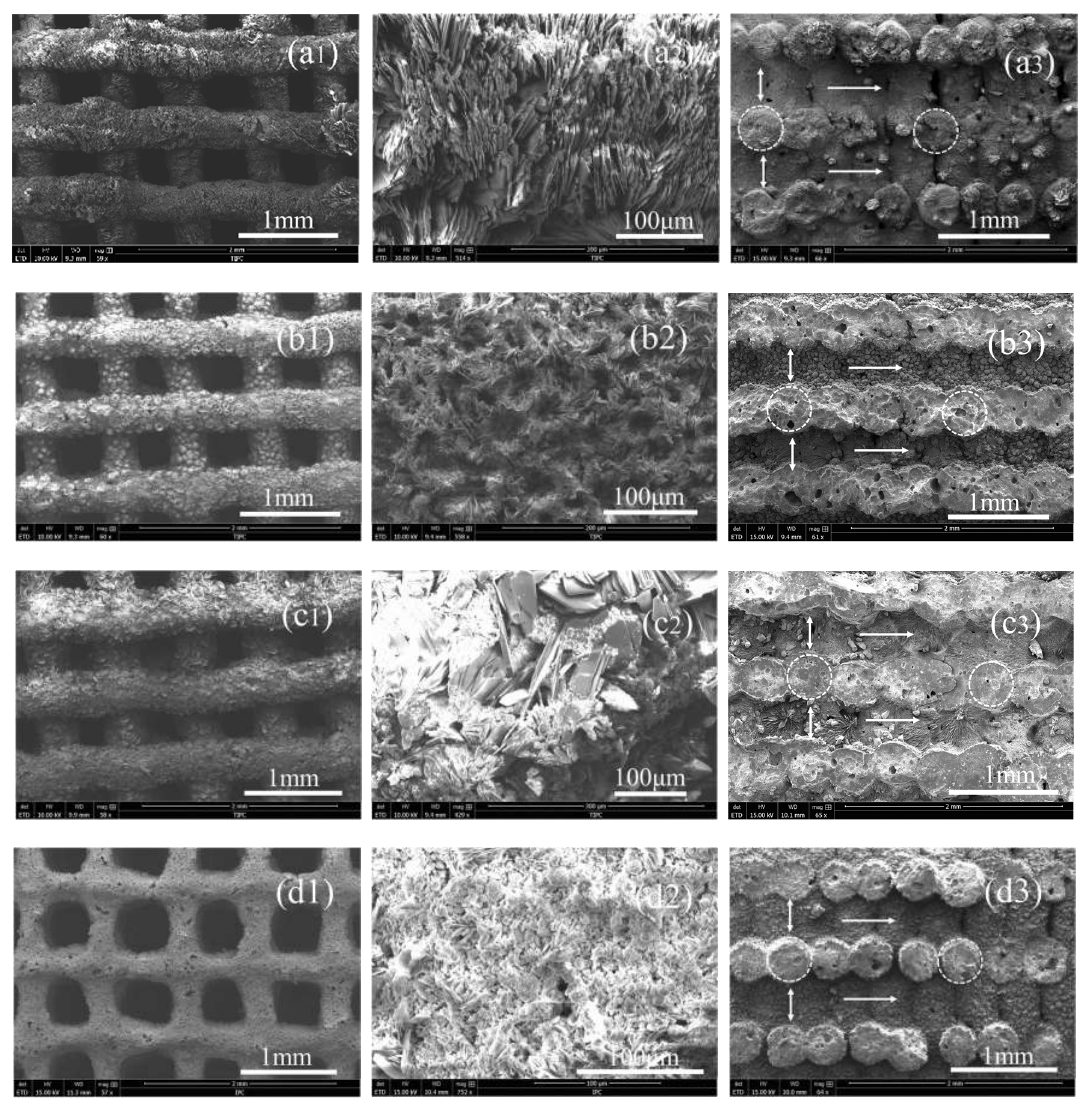
Figure 4. SEM images of porous composite scaffolds S0, S1, S3, and S5 (( a – d ), respectively), with low-magnification SEM images (a1, b1, c1, and d1), high-magnification SEM images (a2, b2, c2, and d2), and internal structures (a3, b3, c3, and d3).